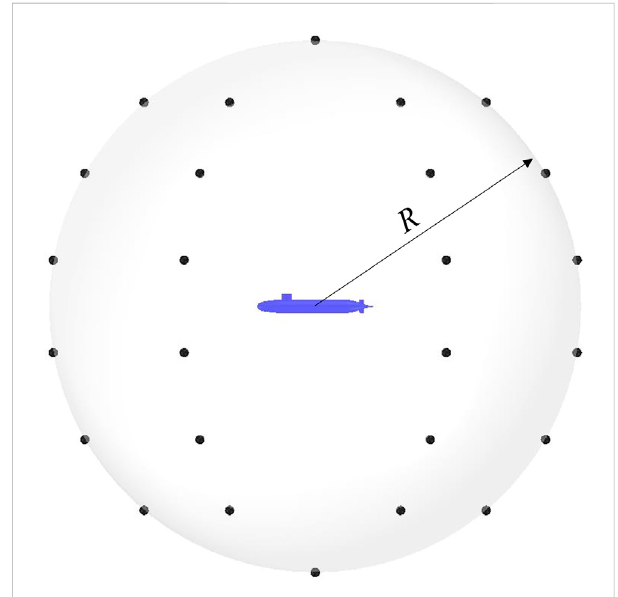
Measuring point location of radiated sound power under